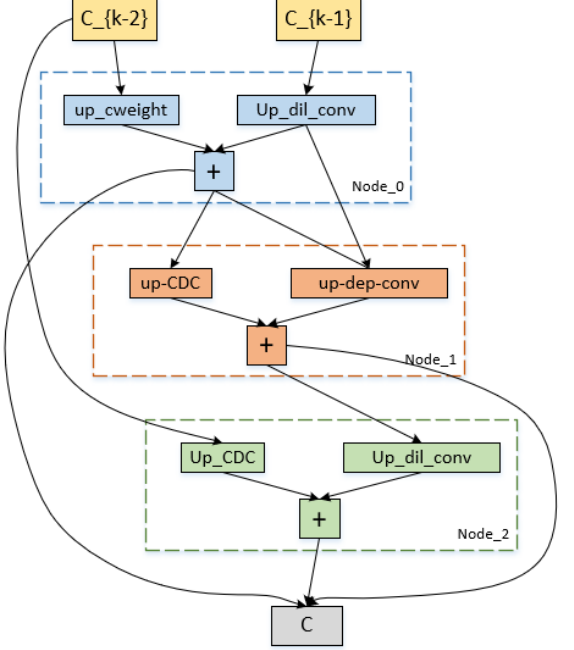
Figure 8. Cell architecture search by our method on the ISBI2015 dataset. It is the up-sampling cell architecture.